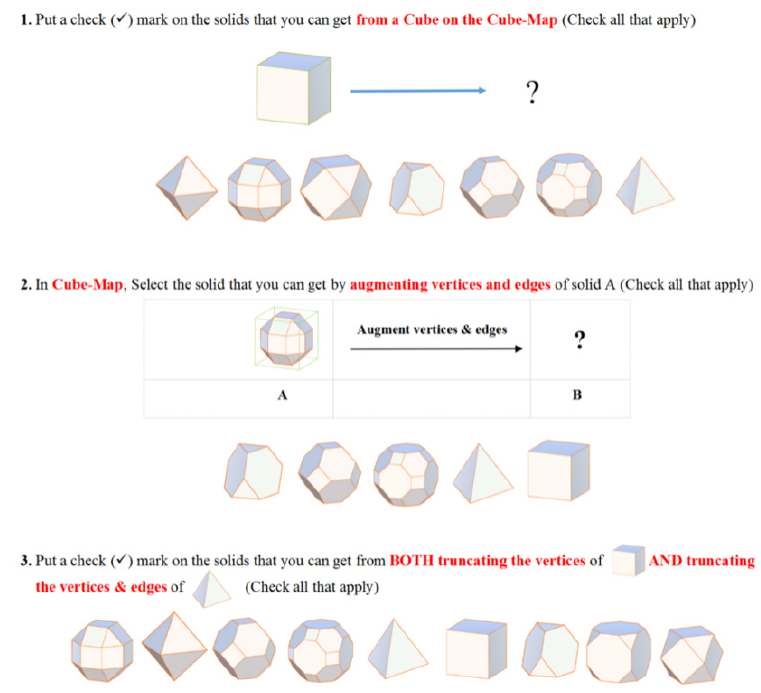
Figure 7. Some sample tasks used in this study.